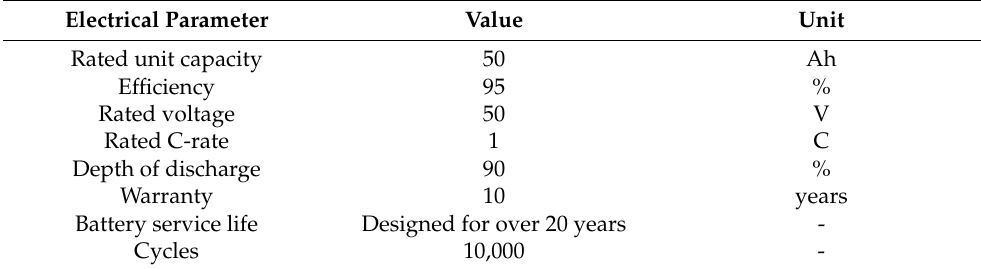
Table 2. Single battery unit